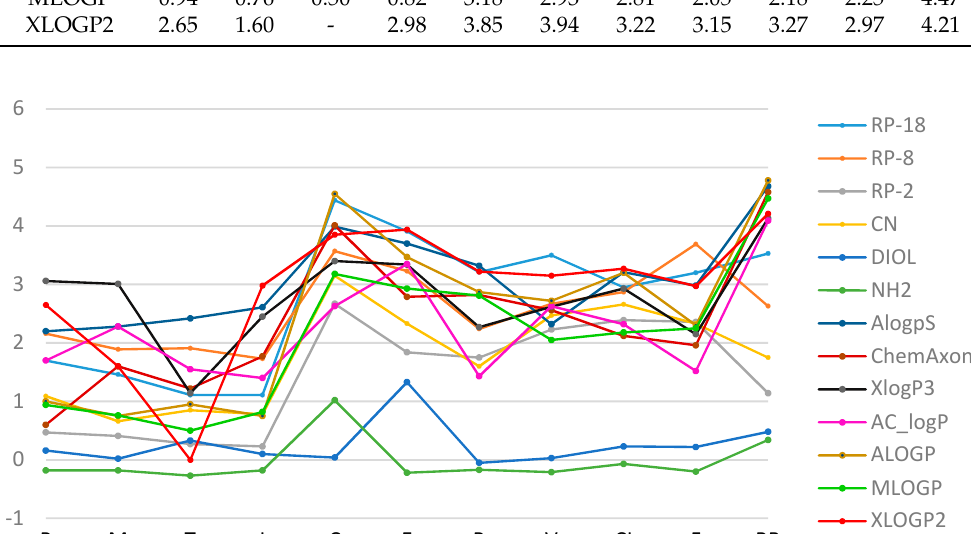
Figure 3. A plot of the relationship of R M0 values for the tested substances obtained experimentally (in the methanol/water mobile phase) and by calculation methods.